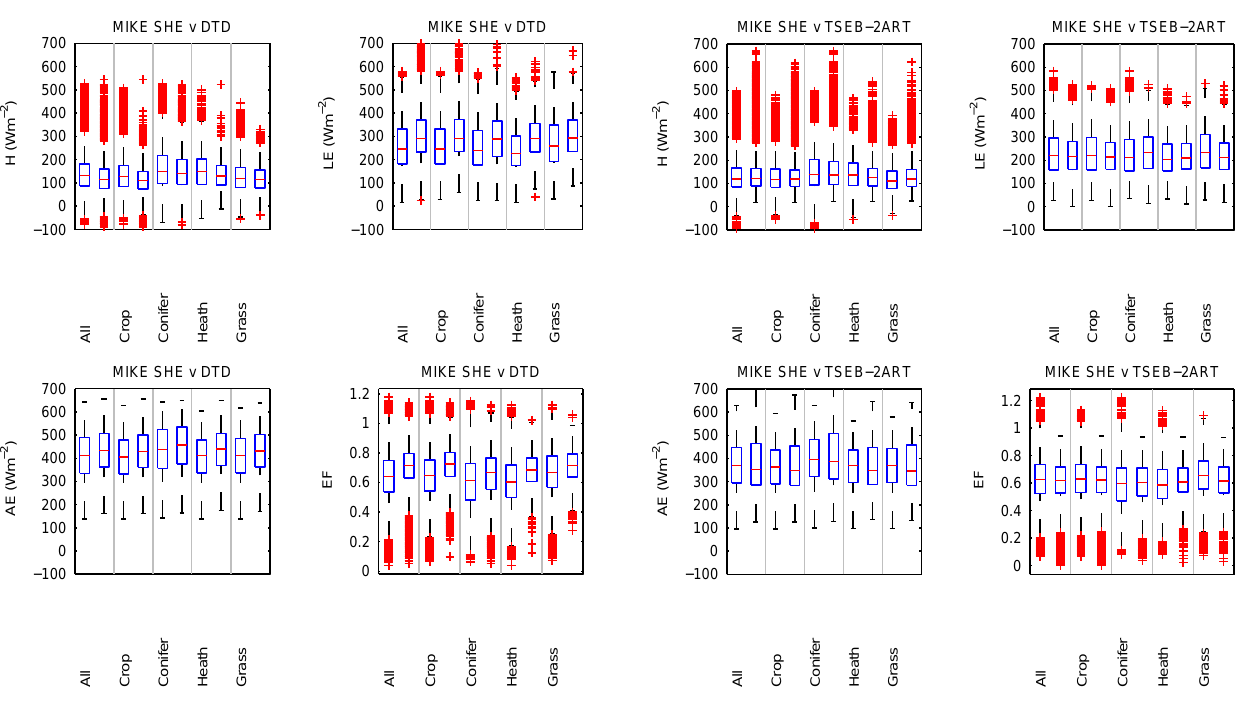
Figure 9. Box plots of sensible heat flux (top left), latent heat flux (top right), net radiation (bottom left) and evaporative fraction (bot- tom right) modelled by MIKE SHE (leftward box in each cate- gory) and TSEB-2ART (rightward box in each category) and split by land cover class. The red horizontal line indicates the median value with the upper and lower box edges indicating the 75th and 25th percentiles respectively. The whiskers extend to the furthest point within 1.5 times the inter-box range above or bellow the box edges with points beyond that categorized as outliers and marked individually as a red